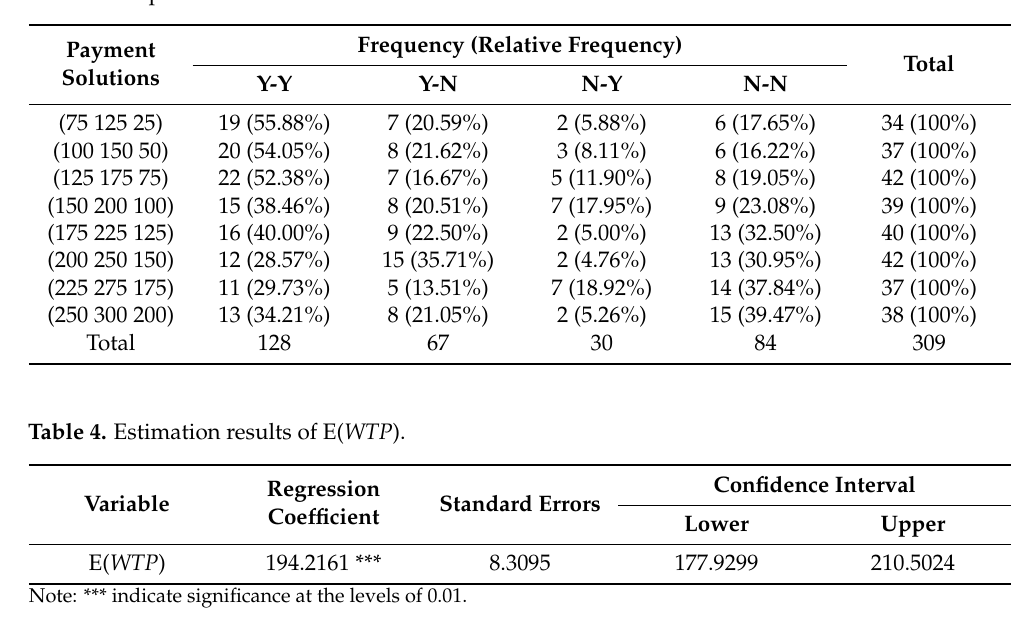
Table 3. Respondents’ WTP statistics.